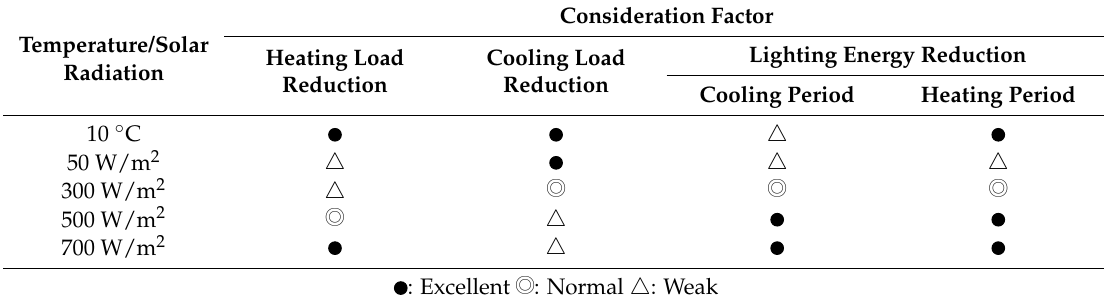
Table 8. Performance of the cooling and heating load, and lighting energy, by controlling Table 3. Performance expected for each condition to control electrochromic glass. Table 3. Performance expected for each condition to control electrochromic glass. Table 3. Performance expected for each condition to control electrochromic glass. electrochromic glass. Table 3. Performance expected for each condition to control electrochromic glass. Table 3. Performance expected for each condition to control electrochromic glass.